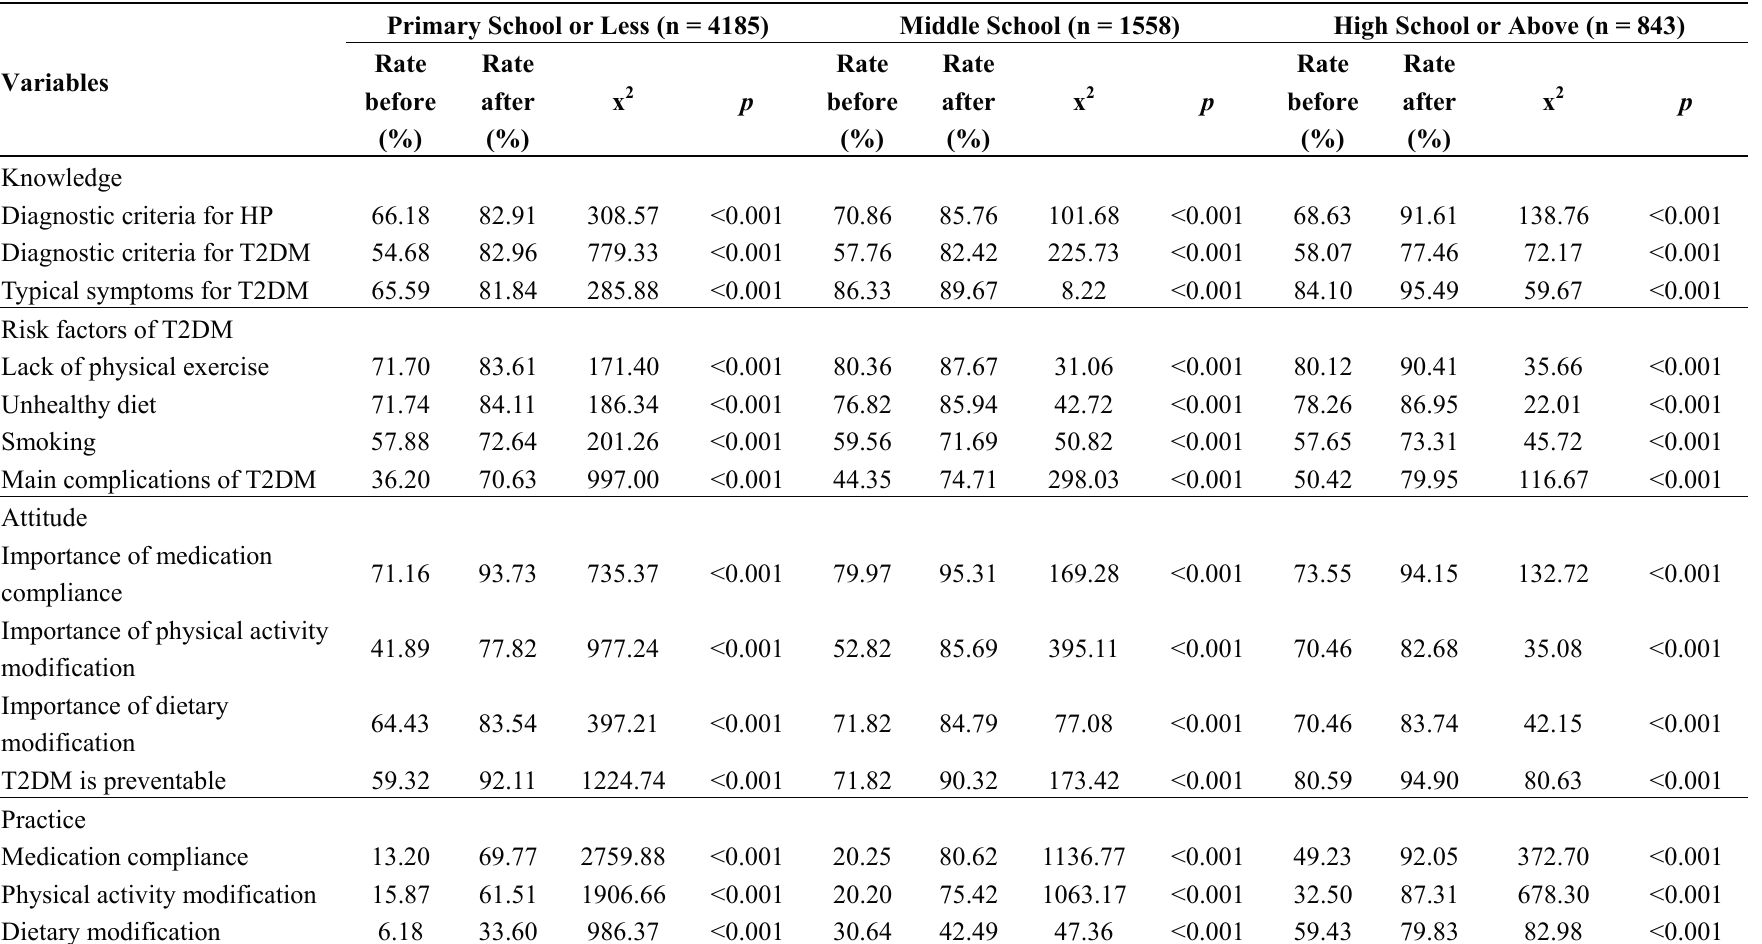
Table 4. Changes of patients’ KAP pre- and post- intervention according to education